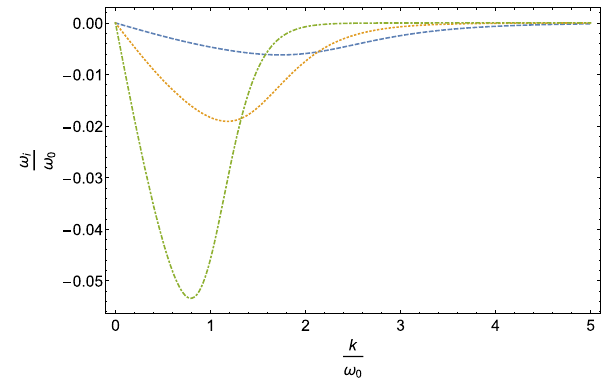
Fig. 1 Normalizeddampingcoefficient ¯ ω i vsnormalizedwavenumber ¯ k for different values of the parameter x : x = 1 (dashed curve), x = 2 (dotted curve), x = 5 (dot-dashed curve)